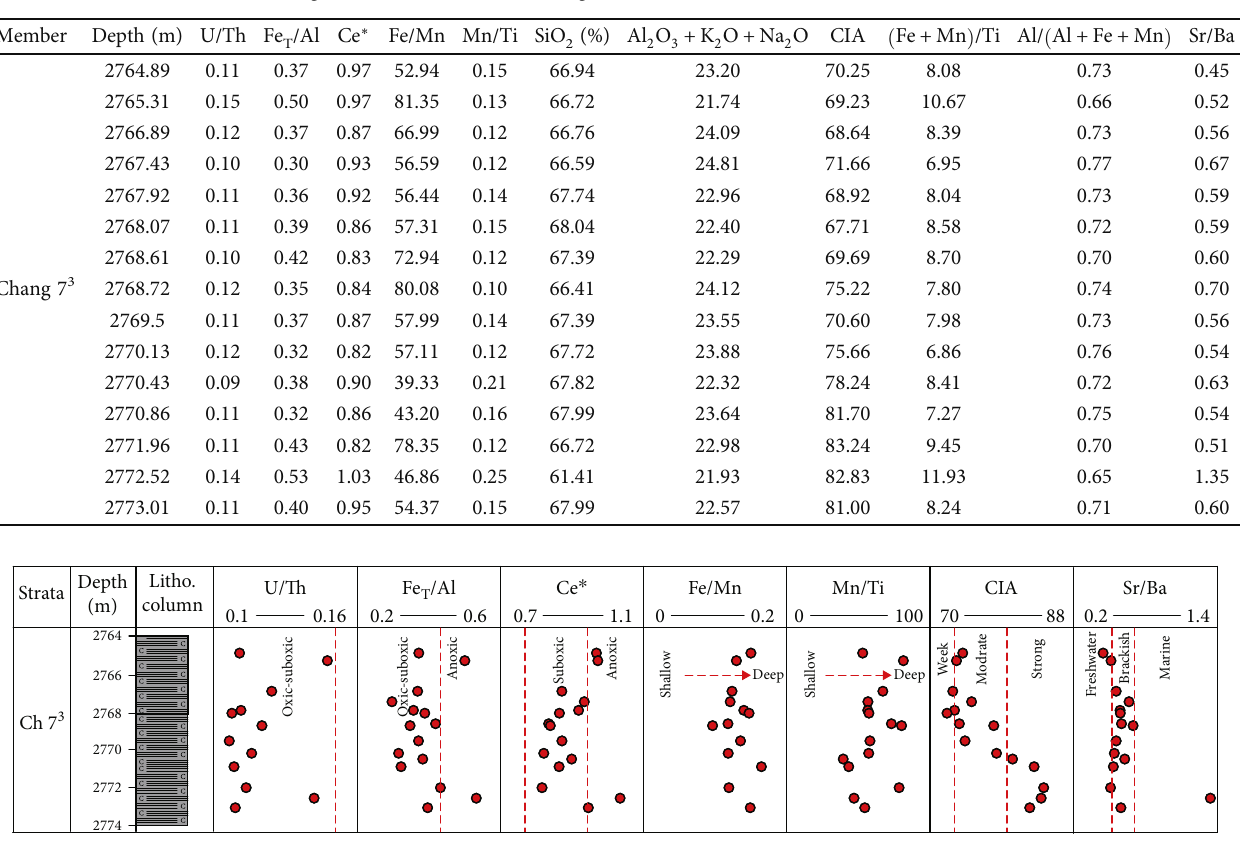
Table 5: Element geochemical data for of Chang 7 3 interval from well DP1 in the western Ordos Basin.